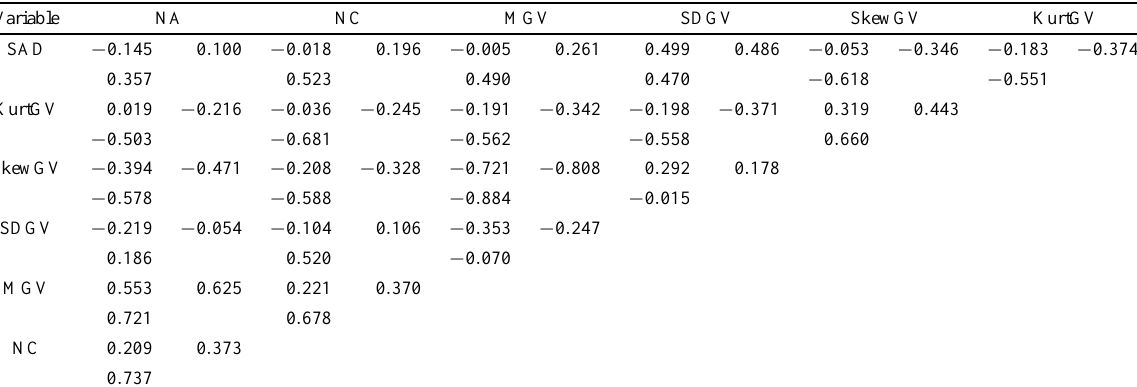
Pearson correlation coefficients between karyometric features. In each cell, uppermost left CC is for cell-level (MLwiN), lowermost left CC for tumor-level (MLwiN), and right CC is that obtained in the “pooling”